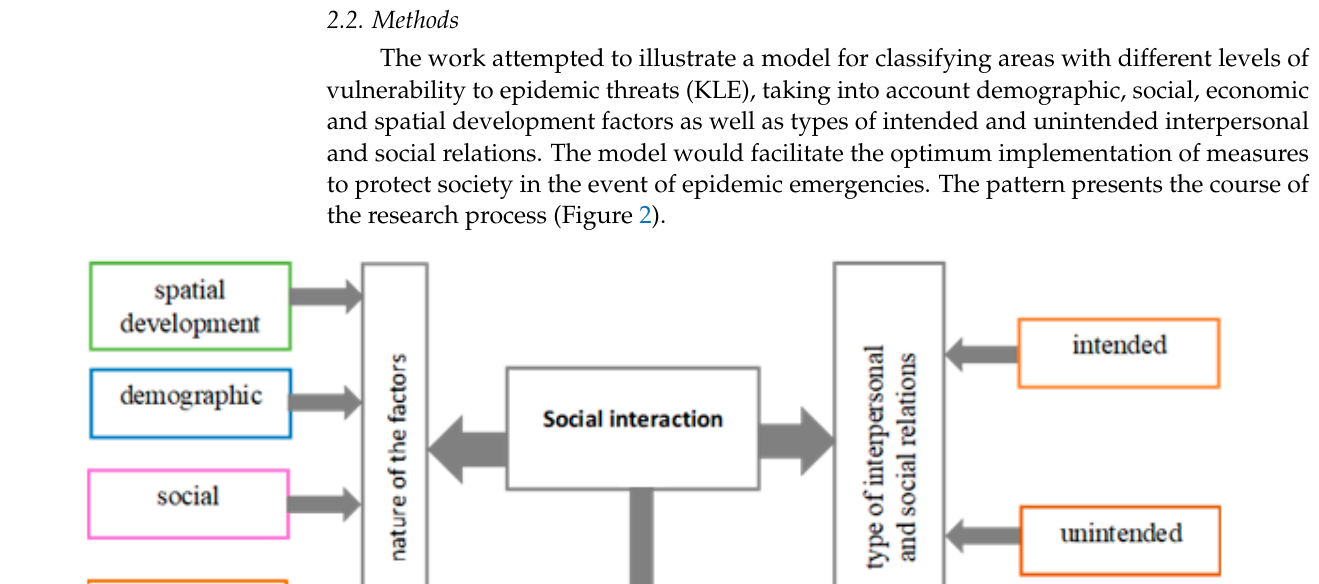
Figure 1. Location study area. ( A ) Location of Poland in Europe. ( B ) Level LAU 1. Source: Own elaboration.